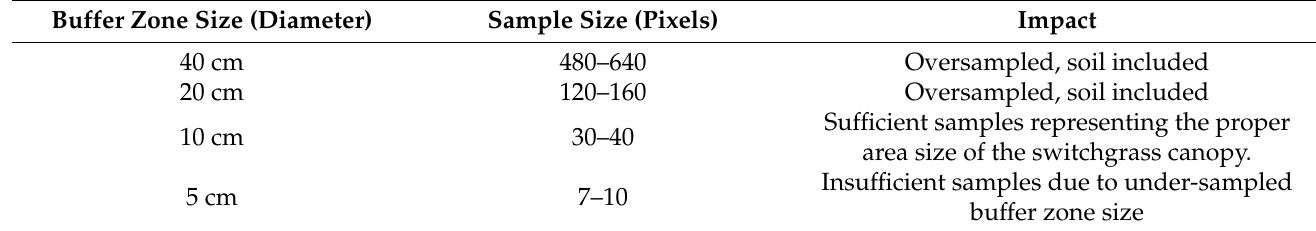
Table 7. Buffer zone sizes and their impact on the image